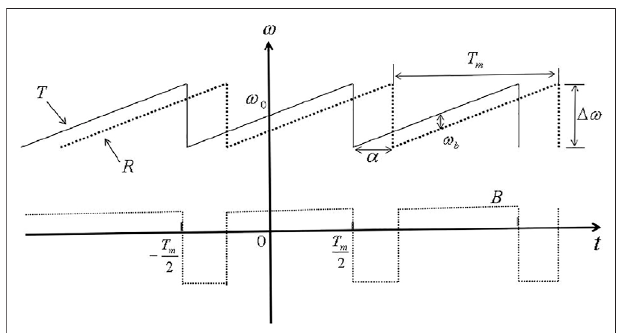
FIGURE1| Therelationshipbetweenangularfrequencyofthesawtooth wave interference signal and the generated beat frequency